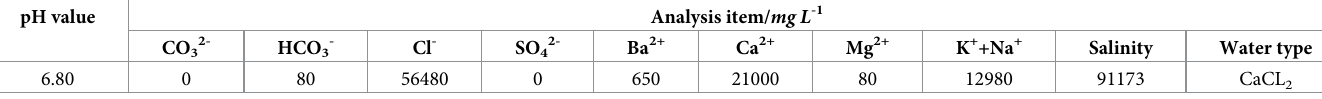
Table 2. Formation water salinity.